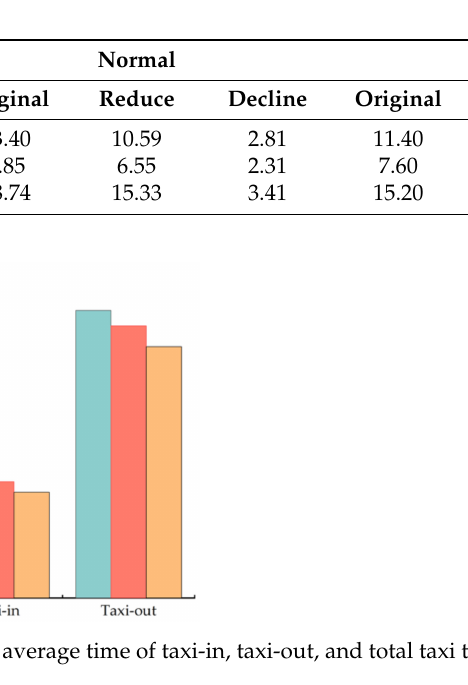
Table 6. Average time of taxi-in and taxi-out and total taxi time under three scenarios before and after optimization (unit: min).